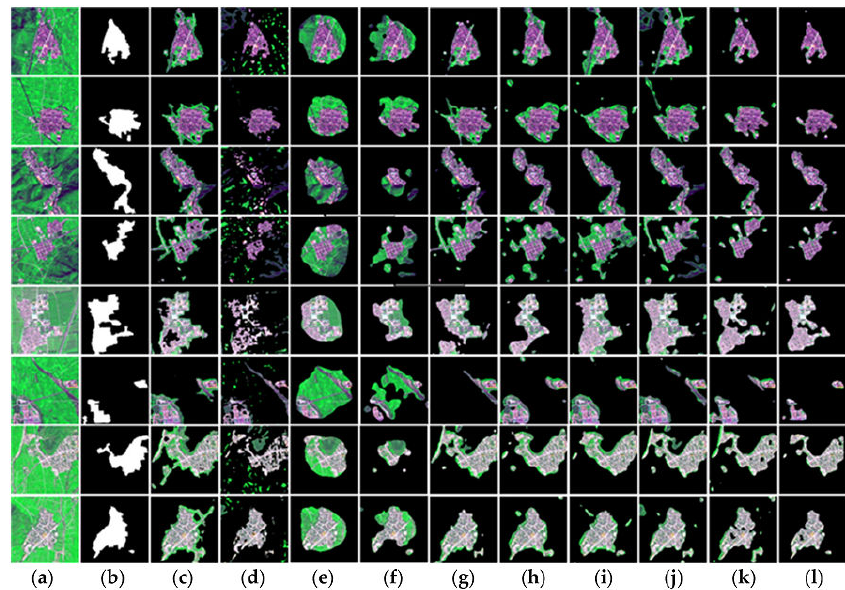
Figure 7. ROIs extracted by our proposed model and nine competing models on SPOT 5 images. ( a ) Origin images; ( b ) Ground truth; ( c ) CA; ( d ) FT; ( e ) GBVS; ( f ) ITTI; ( g ) WT; ( h ) SR; ( i ) MFF; ( j ) SACH; ( k ) FDA and ( l ) ours.